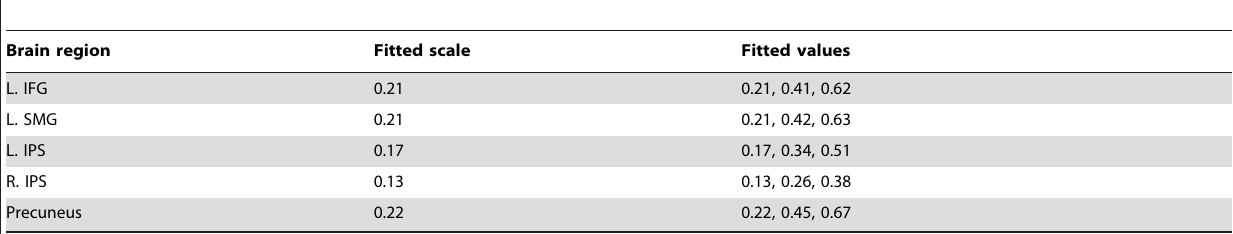
Table 4. The results of fitted scale and values for each activated region, by using ‘‘DoM in the hierarchical tree structures’’.